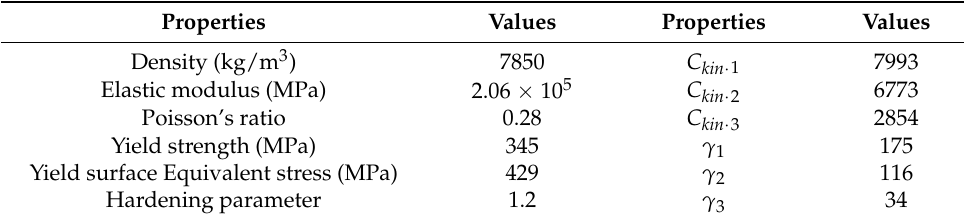
Table 1. Parameters of the constitutive law of steel.